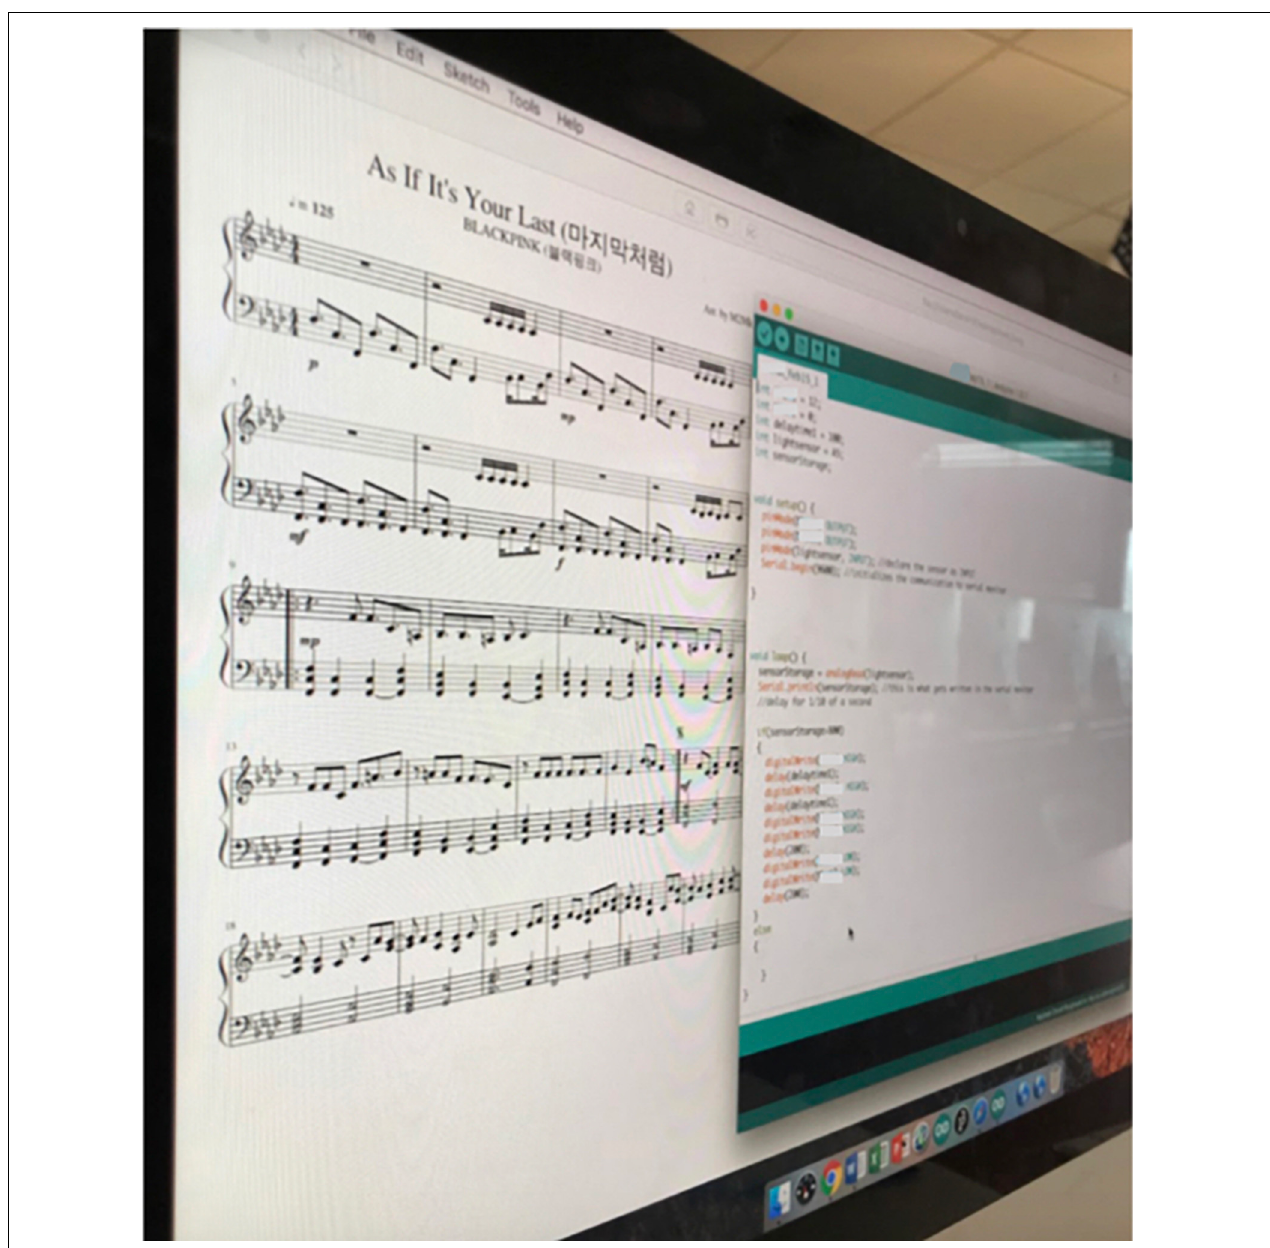
FIGURE 5 | Jae’s computer screen as he transcribed musical notes into